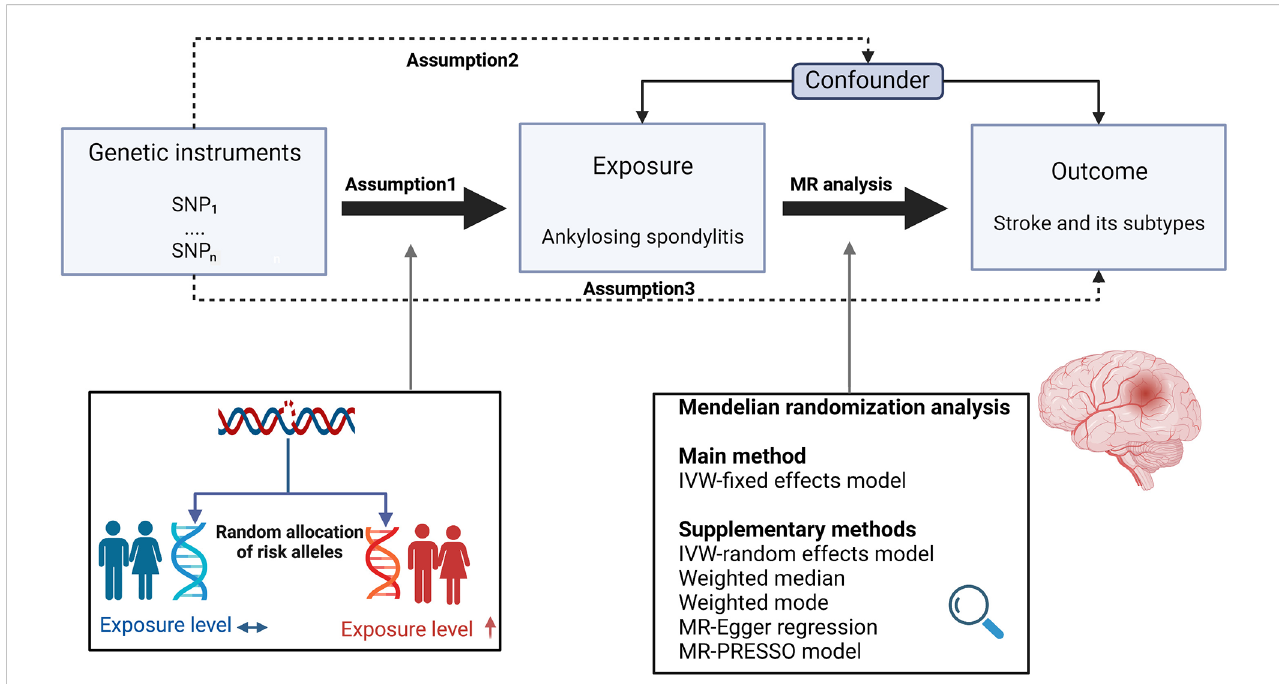
FIGURE 1 Study design overview and assumptions of the MR design. Assumption 1 indicates that the genetic variants proposed as instrumental variables should be robustly associated with the risk factor of interest, assumption 2 indicates that the used genetic variants should not be associated with potential confounders, and assumption 3 indicates that the selected genetic variants should affect the risk of the outcome merely through the risk factor, not via alternative pathways. The MR design can reduce residual confounding and reverse causality, thereby reinforcing the causal inference of an exposure outcome association. The basis of this is that genetic variants, selected as an instrumental variable for studying the effect of modifying the exposure, are randomly allocated at conception and are therefore less vulnerable to confounding from environmental factors and reverse causation. IVW, inverse- variance weighted. (Created with